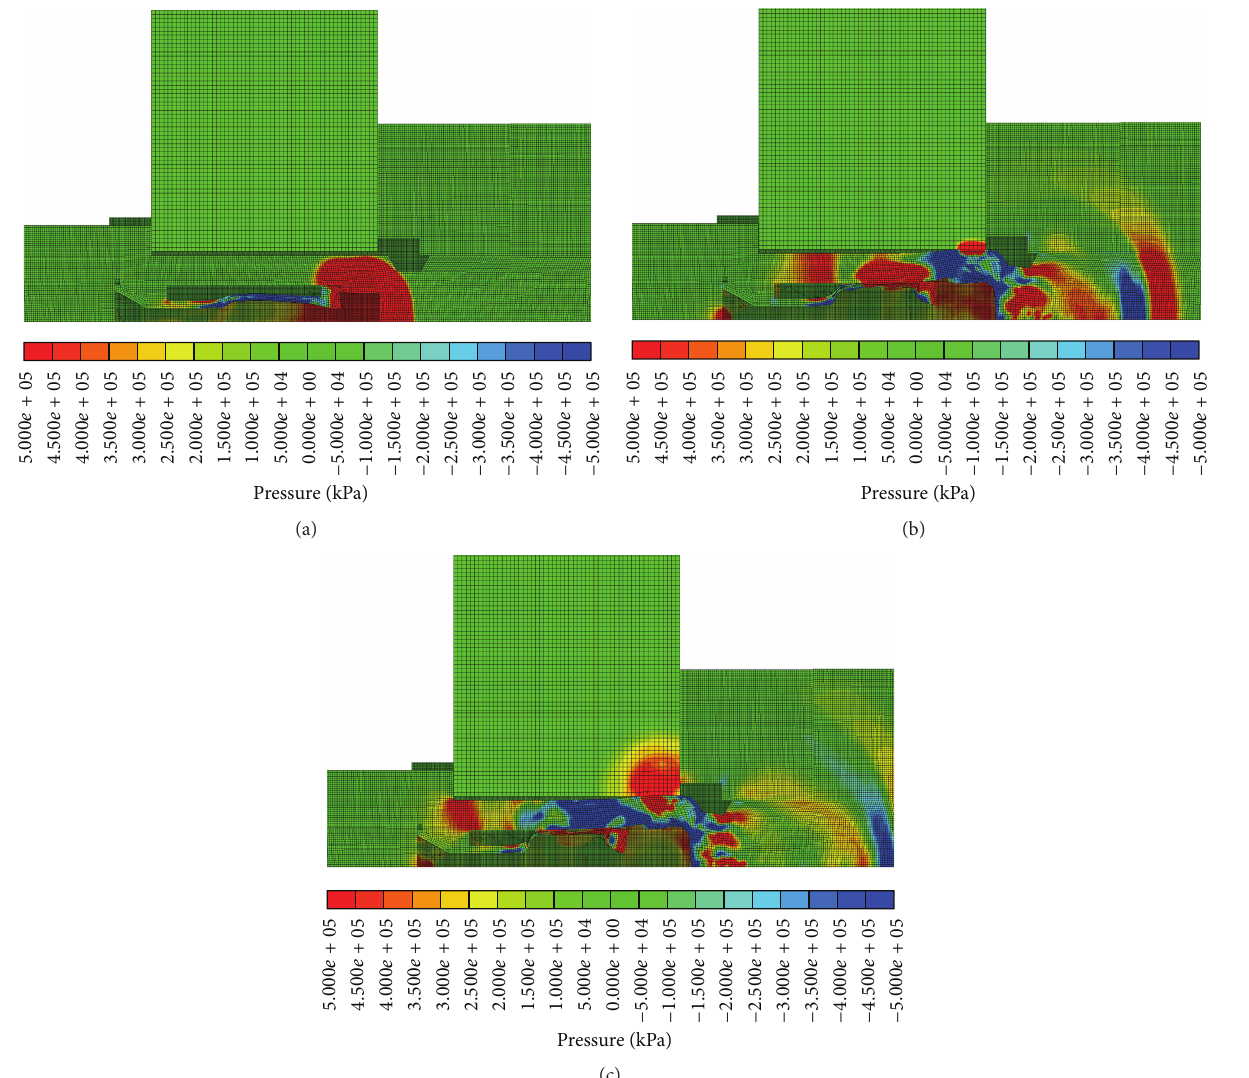
Figure 15: Pressure contours of the ridge-cut explosive bolts with a 22 mm thickness circular plate: (a) at 2.5 𝜇 s, (b) at 5.1 𝜇 s, and (c) at 6.0 𝜇